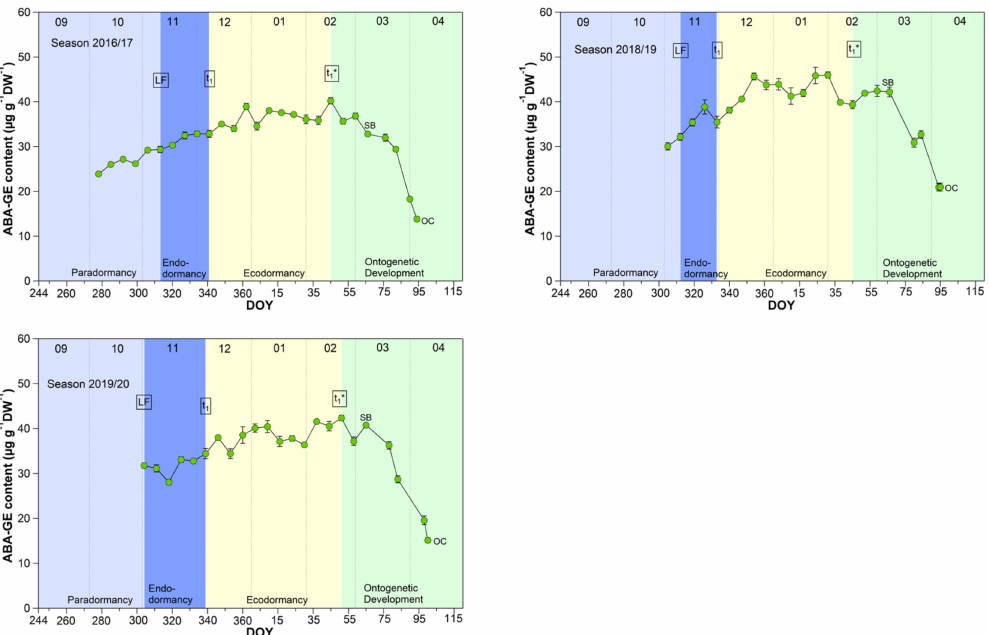
Figure 6. Abscisic acid glucose ester (ABA-GE) in sweet cherry buds cv. Summit, 2011/12–2019/20. ‘Total leaf fall’ (LF), endodormancy release (t 1 ), beginning of ontogenetic development (t 1 *), ‘swollen bud’ (SB) and ‘open cluster’ stage